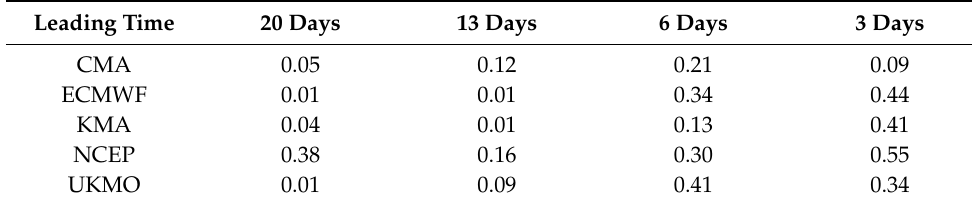
Table 3. TCs of cumulative rainfall prediction during 18–22 July in Henan.